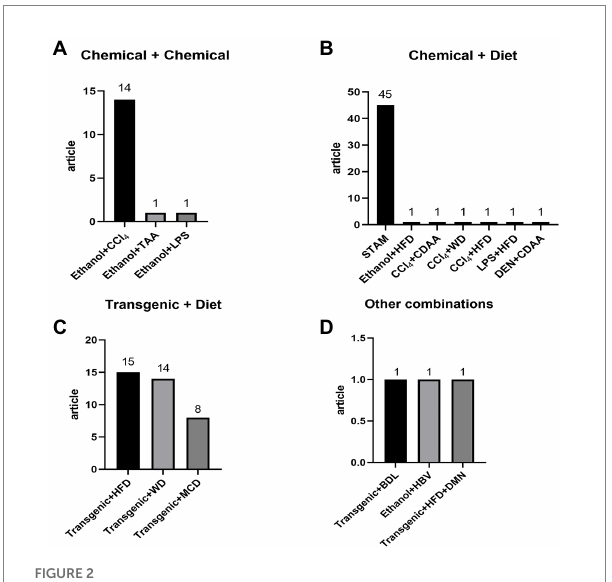
FIGURE 2 Detailed distribution of combine induction